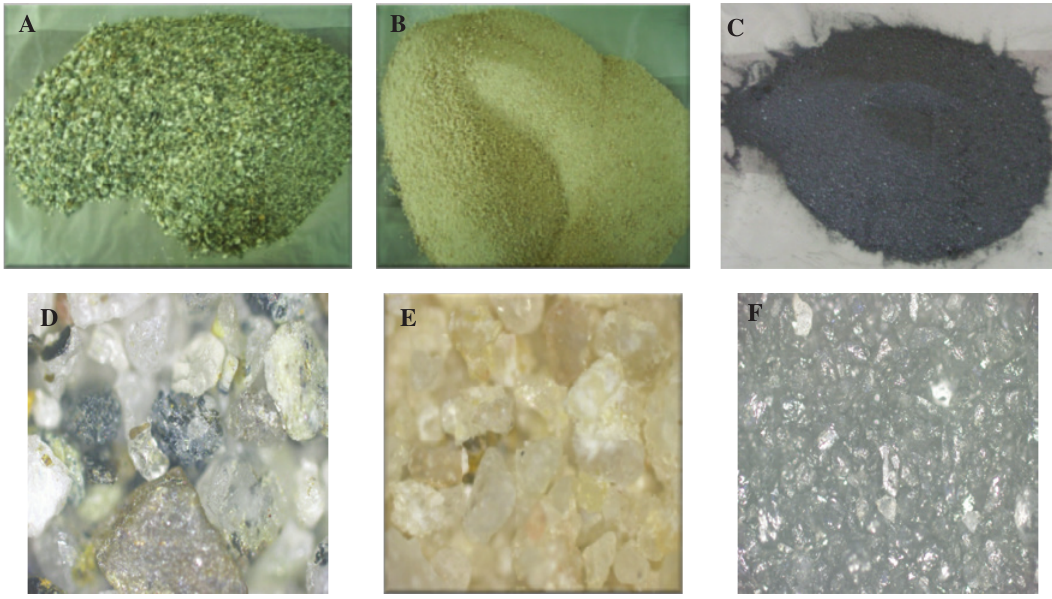
Figure 4: Images of natural sand and UFSs by the naked eye (A–C) and by optical microscopy (D–F). (A) NLS, (B) FSS, (C) FPR, (D) NS-50 × , (E) FSS-50 × and (F) FPR-50 ×